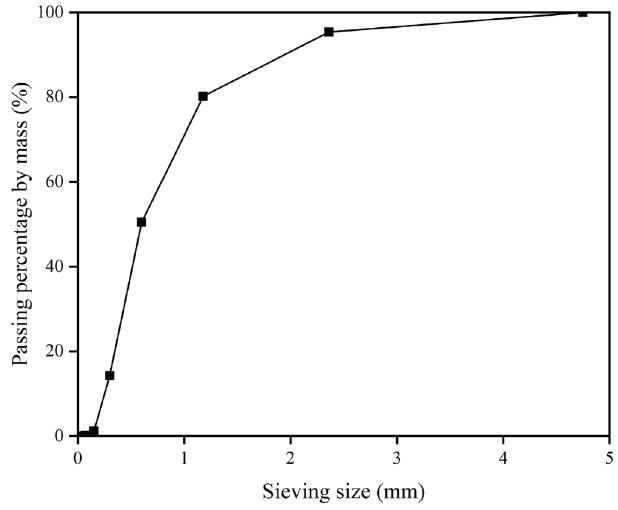
Figure 2. Particle size distribution curve for the quartz sand used in this investigation.